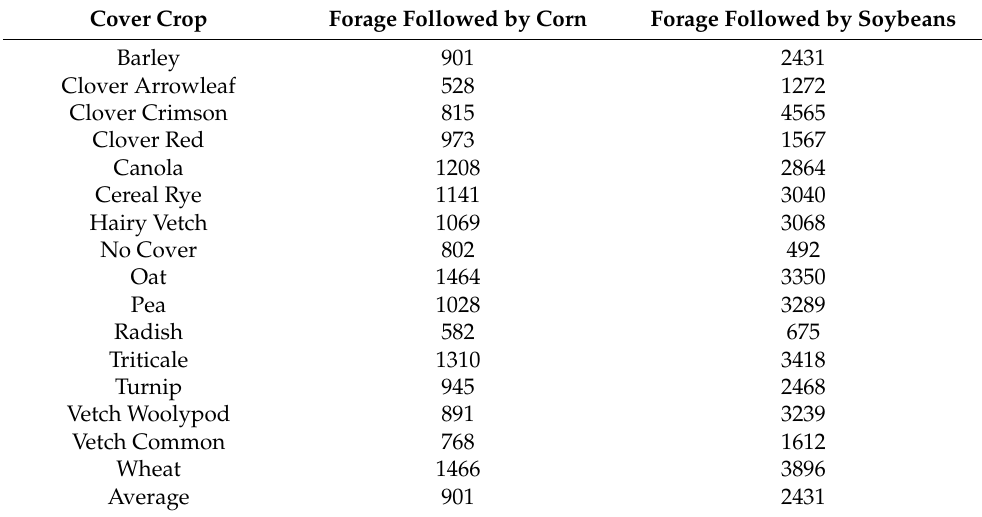
Table 3. Average forage yields for the cover crops by succeeding cash crop across all years (2018 and 2019) and Locations (Knoxville, TN, USA; and Spring Hill, TN,